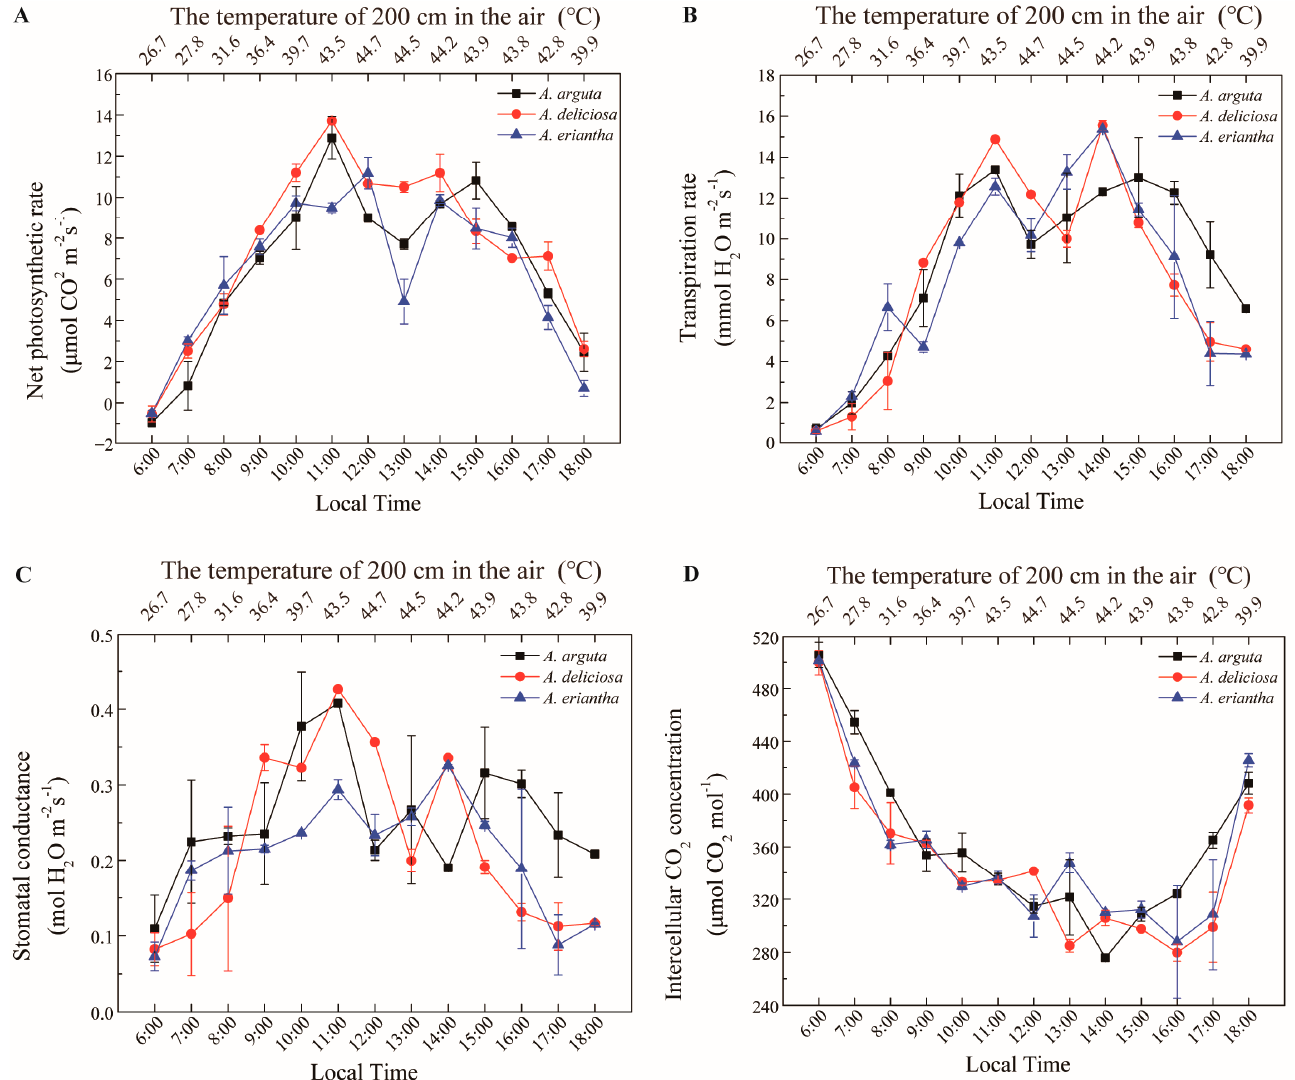
Figure 6. Net photosynthetic rate ( A ) ( μ mol CO 2 m − 2 s − 1 ), transpiration rate ( B ) (mmol H 2 O m − 2 s − 1 ), stomatal conductance ( C ) (mol H 2 O m − 2 s − 1 ) and intercellular CO 2 concentration ( D ) ( μ mol CO 2 mol − 1 ) changes of diploid, tetraploid and hexaploid kiwifruit cultivars at high temperatures.